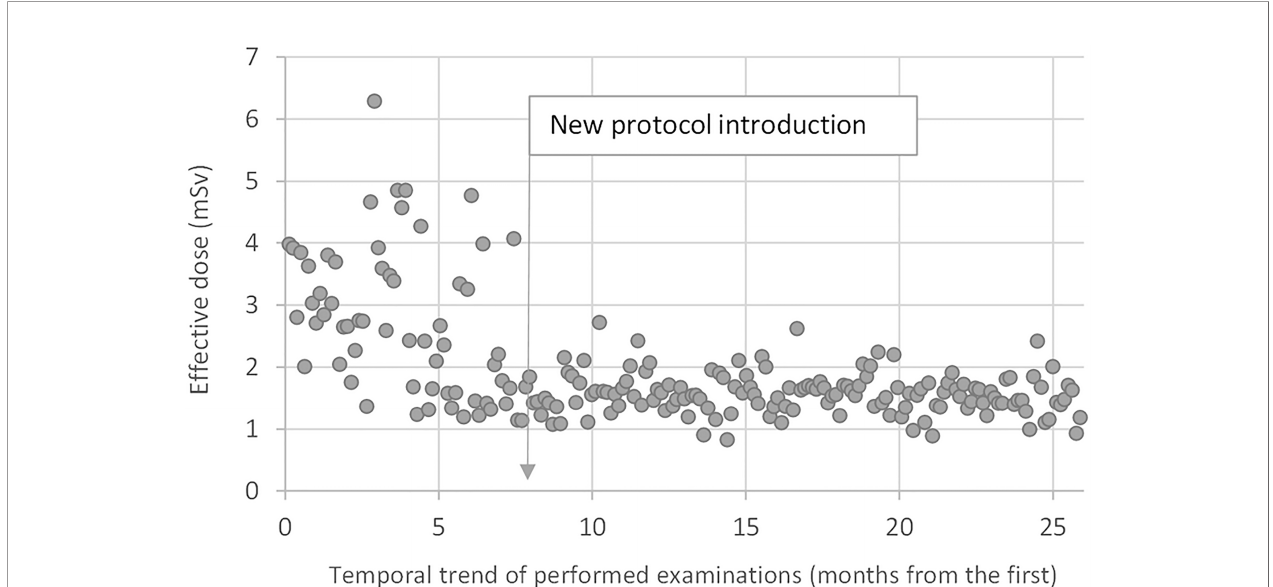
FIGURE 4 | Temporal trend of the patient effective doses. The median E-value was about 2.6 mSv in the fi rst 8 months of examinations with the standard protocol and about 1.5 mSv after the introduction of the optimized protocol.